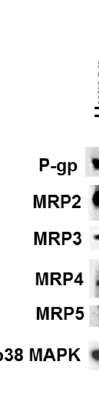
Figure 2. Drug transporter protein expression in HuH-7 cells. Protein content was determined in HuH-7 cells and freshly isolated human hepatocytes by Western-blotting. Data shown are representative of three independent assays (HuH-7 cells) or of three independent populations (human hepatocytes). P-gp, P-glycoprotein; MRP, multidrug resistance-associated protein; MAPK, mitogen-activated protein kinase.